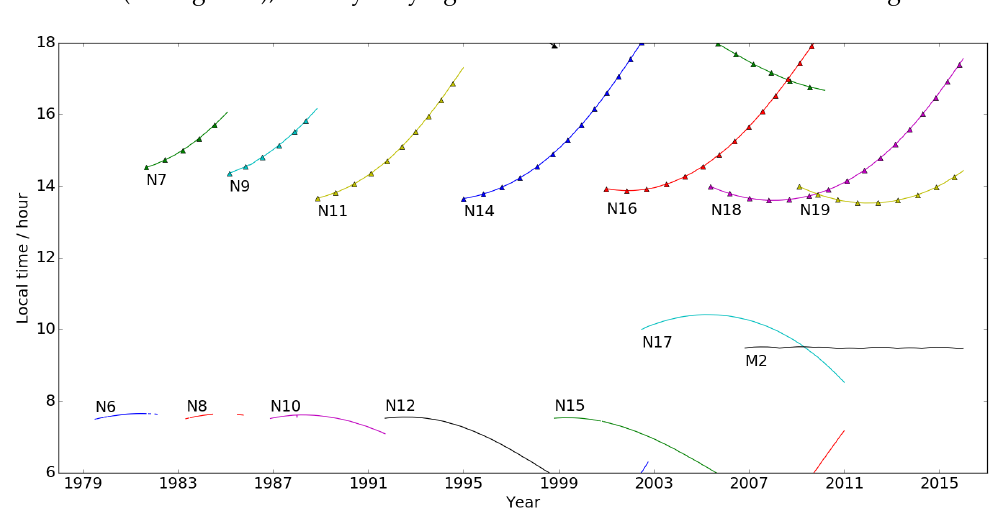
Figure 1. Daytime equator overpass times for AVHRR sensors as a function of instrument